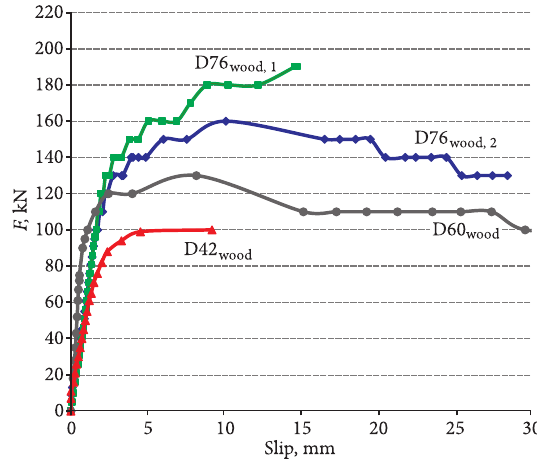
Fig. 6. Laboratory setup of the push-out test Fig. 7. Force-slip graph of the connectors with a wood